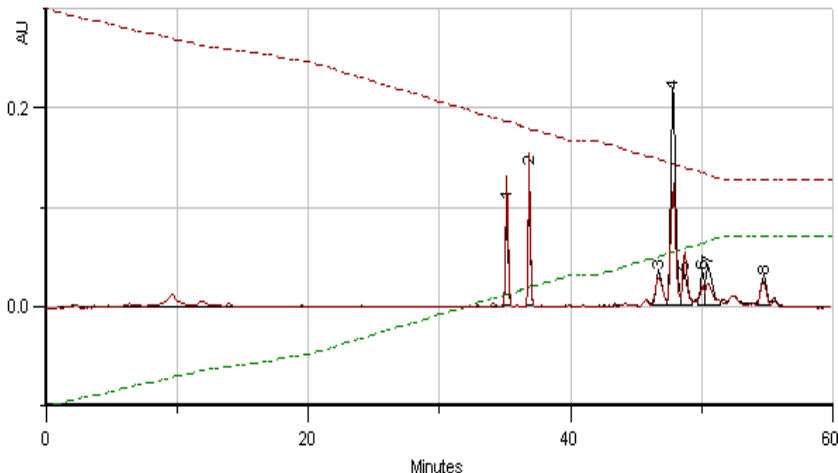
Figure 5. HPLC/DAD profile of pure rape pollen sample (these analyses were carried out with pollen from Slovakia). The profile is identical and the ultraviolet (UV) spectra of each compound have the similar correspondence as presented in Figures 2 and